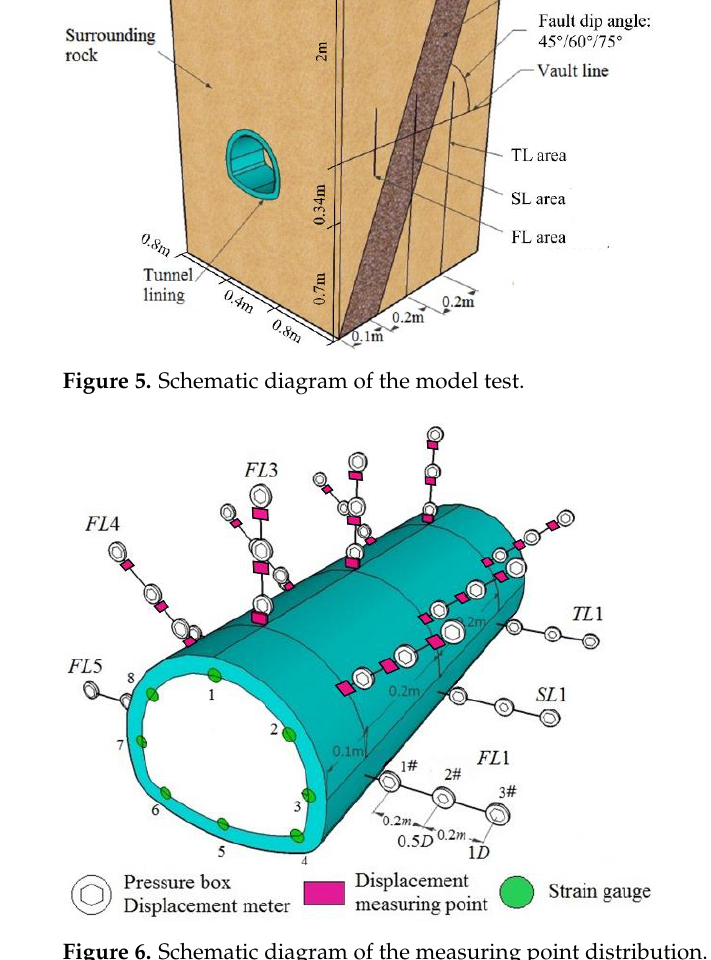
Figure 6. Schematic diagram of the measuring point distribution. Table 2. Physical and mechanical parameters of rock